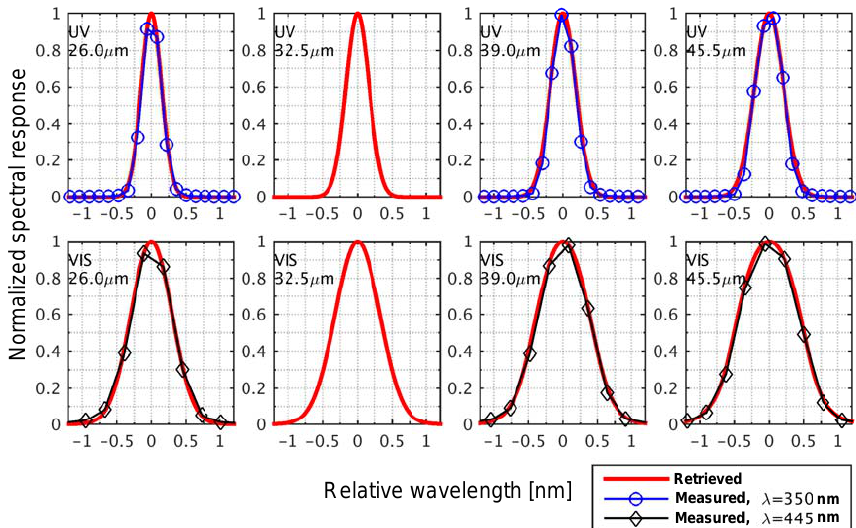
Figure 5. Slit function shapes retrieved from nadir radiance data for UV and VIS spectrometers and those recorded post-flight in the labo- ratory at 350 and 445nm for the center FOV position. Data were not collected in the laboratory for the 32.5µm slit due to time constraints. Data for the 39µm slit are shown at 440nm, as 445nm was not recorded.